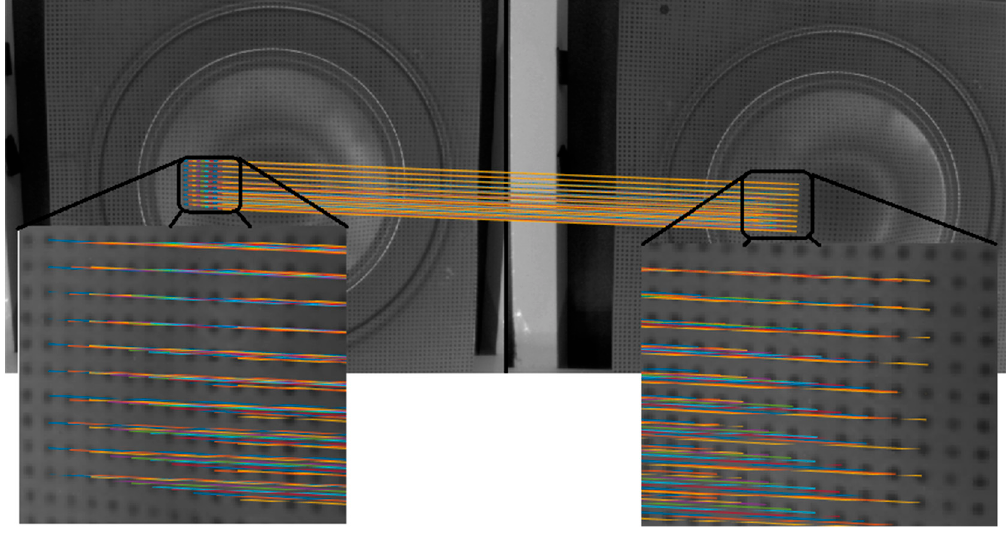
Figure 10. Points matching using the initial condition proposed and verified by Normalized Cross Correlation.